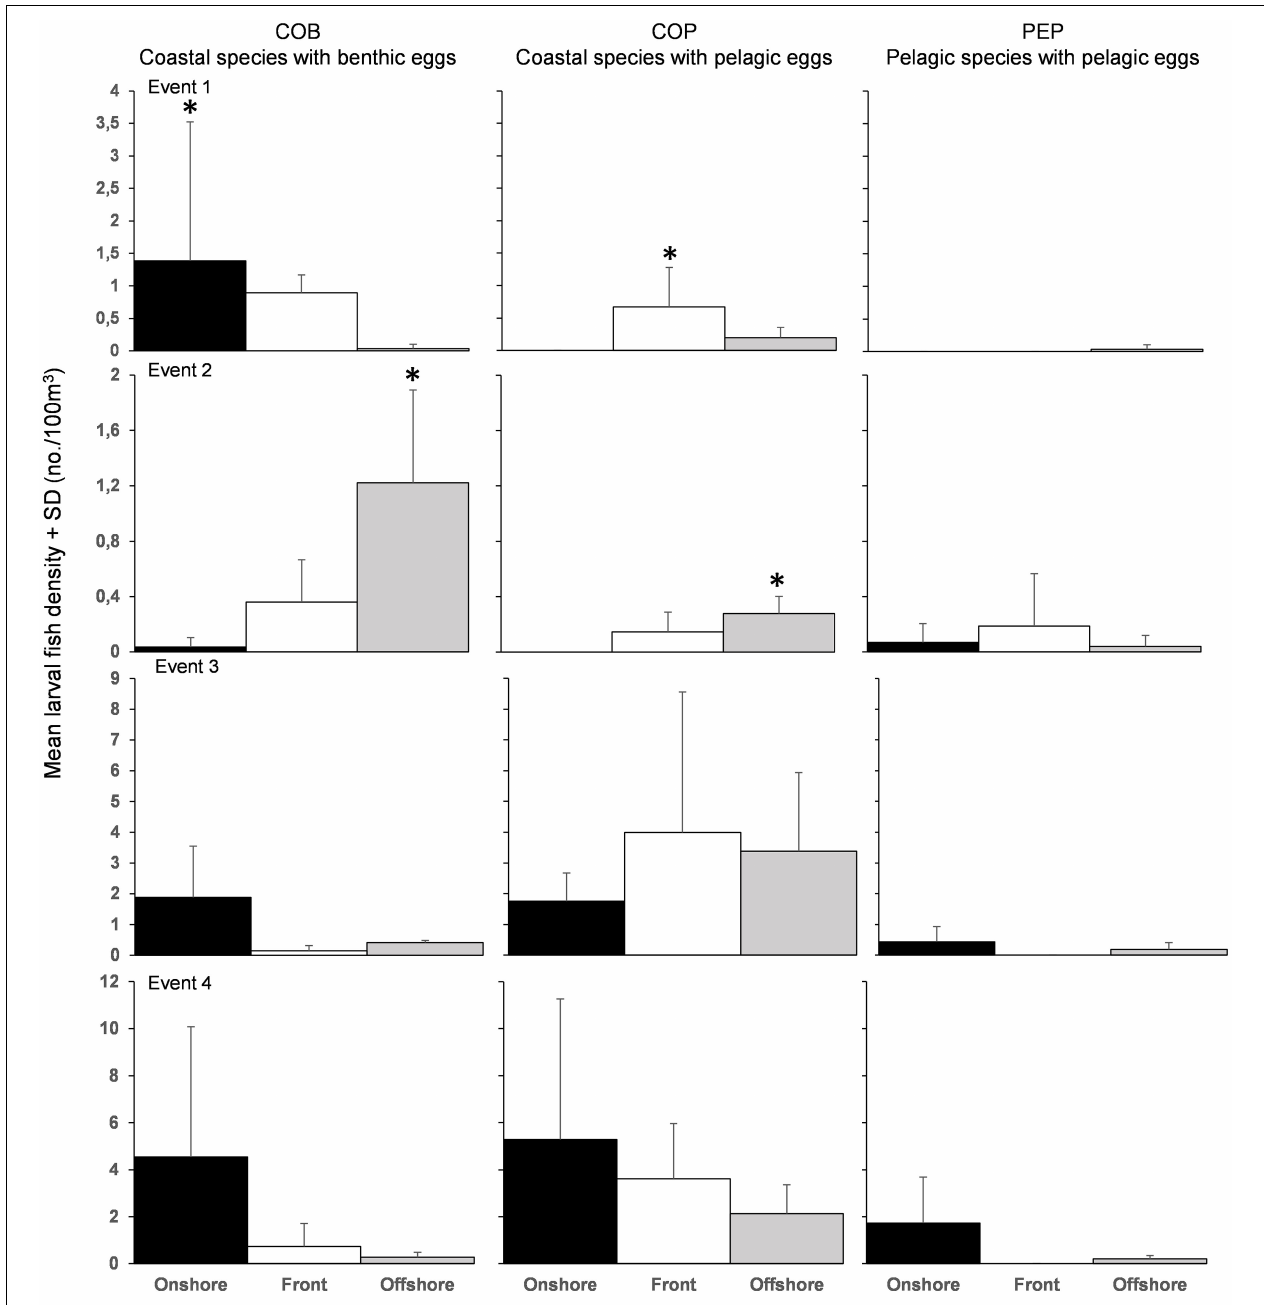
FIGURE 5 | Mean (+SD) larval fish densities of the three categories of life histories found in the onshore (black), the front (white), and offshore (grey). Note change in axis scaling for each event. ∗ Significant accumulation ( p < 0.05).